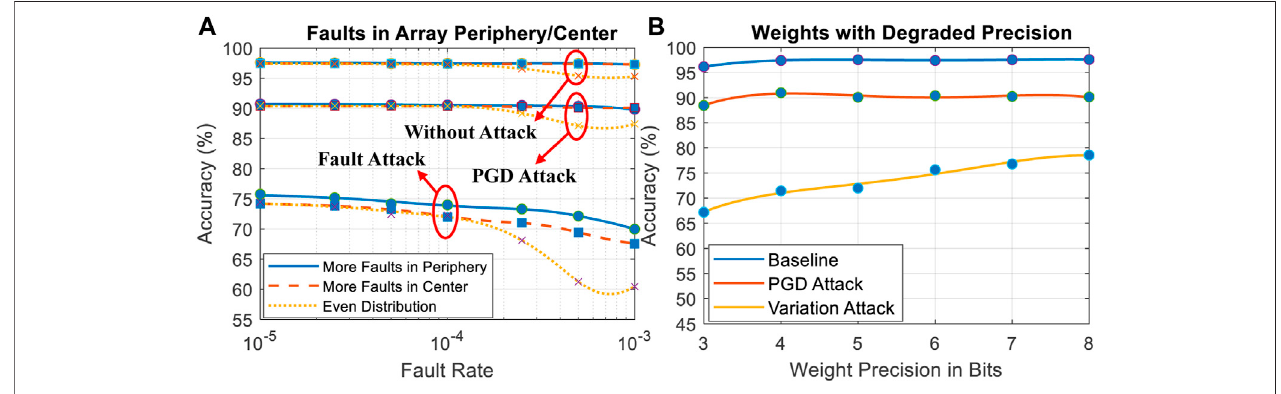
FIGURE 8 | (A) Results of attack Model 3, and (B) results of attack Model 4.